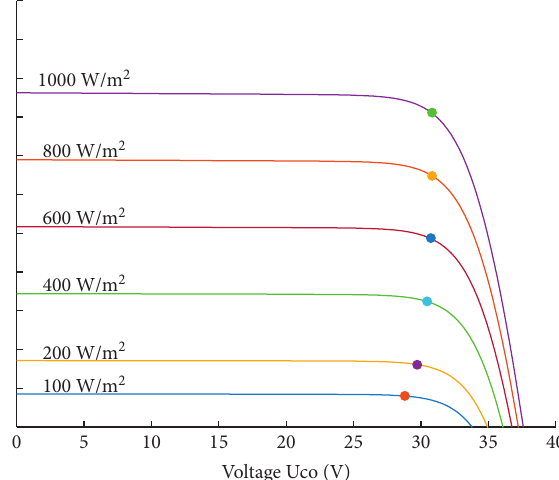
Table 3: The DC parameters of the ENSET PV system.